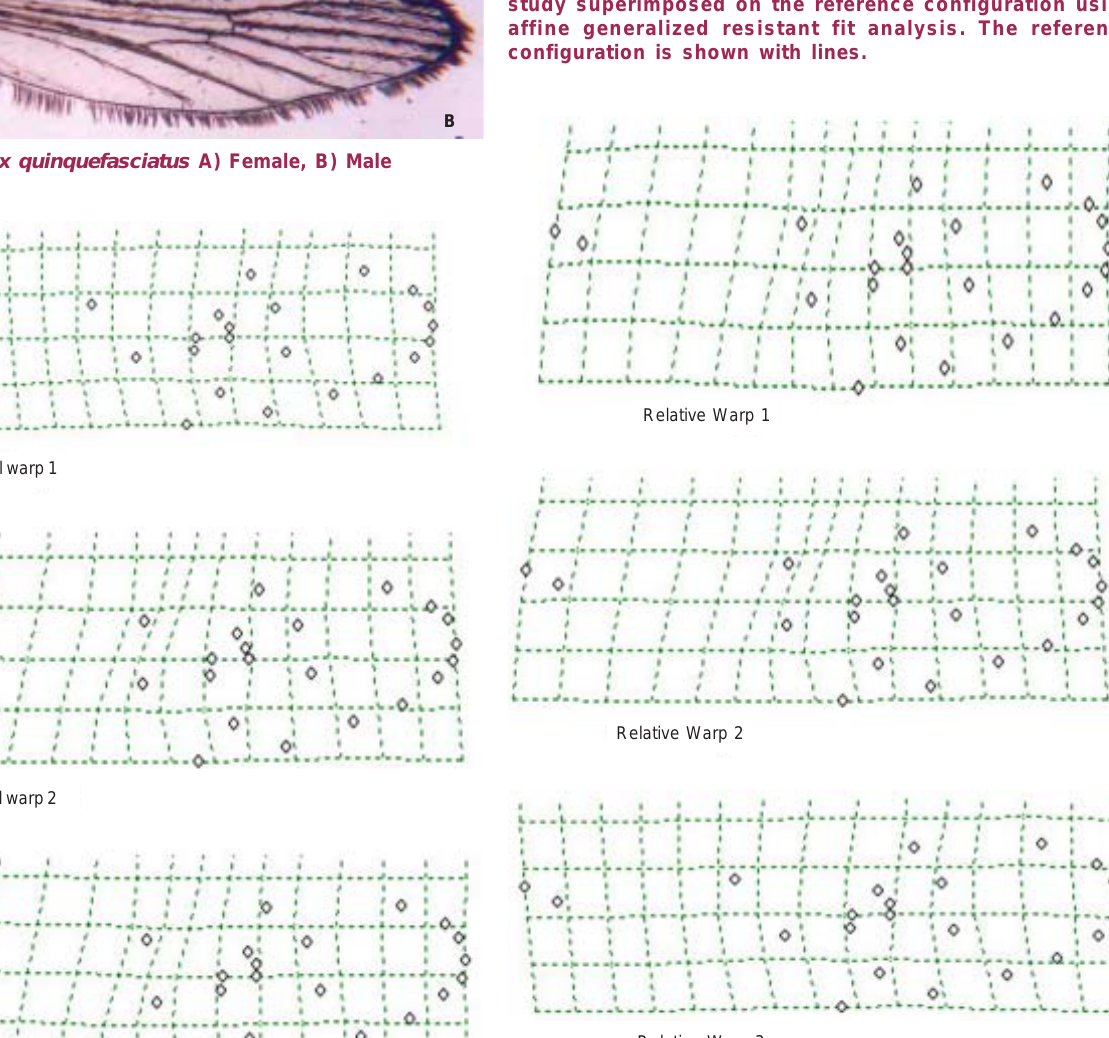
Figure 4. Plots of the relative warp loadings (Alpha = 1) and the grid of the wings superimposed in the reference configuration based on affine generalised resistant fit (Alpha =